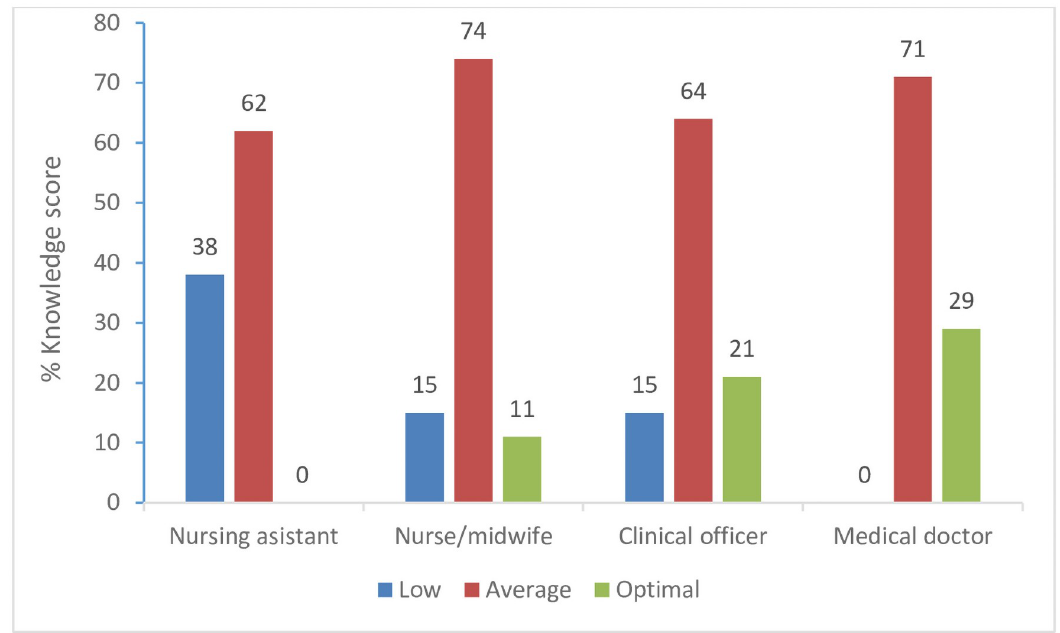
Fig 1. Level of knowledge on management of common childhood illnesses by health workers in LLPHFs in Mbarara district, Uganda by the qualification of the healthcare workers.